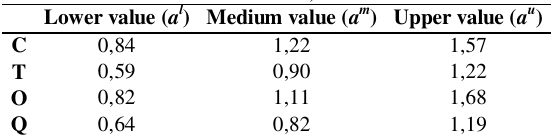
(Table 5) are calculated using Equation (2)-(3). Table 5. Weights of main criteria (with triangular